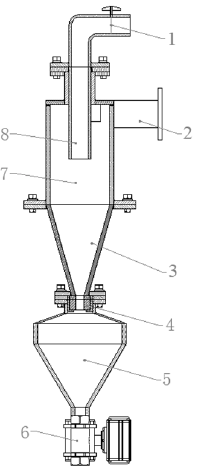
Figure 1. Structure of the intermittent discharge concentrated hydrocyclone. 1—back pressure valve; 2—feeding port; 3—cone segment; 4—underflow orifice; 5—concentrated hopper; 6—pneumatic valves; 7—column segments; 8—overflow pipe.